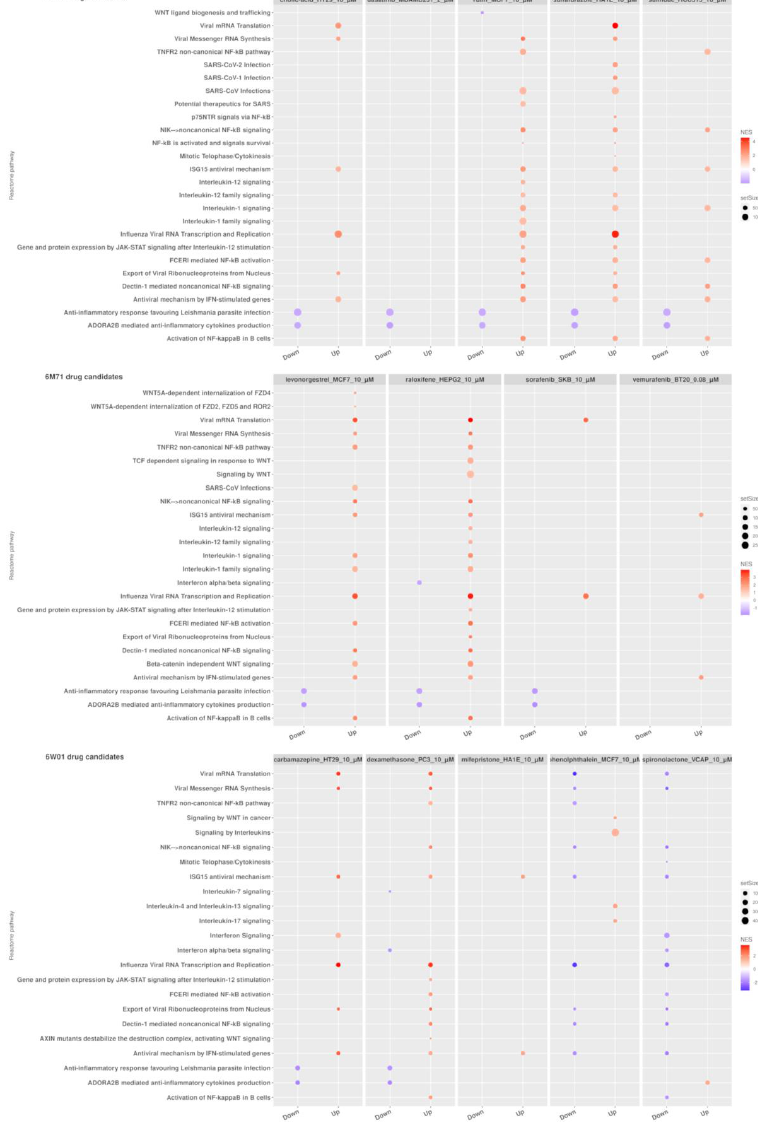
Figure 3. Gene Set Enrichment Analysis (GSEA) results for candidate drugs for 6M2Q, 6M71, and 6W01 SARS-CoV-2 structures with the expression signature yields from correlation analyses from DS2. Reactome pathways related to the immune system and viral infections. Only drugs with at least one pathway with an adjusted p -value < 0.05 are displayed. The GSEA table with the results is available in Supplementary Tables